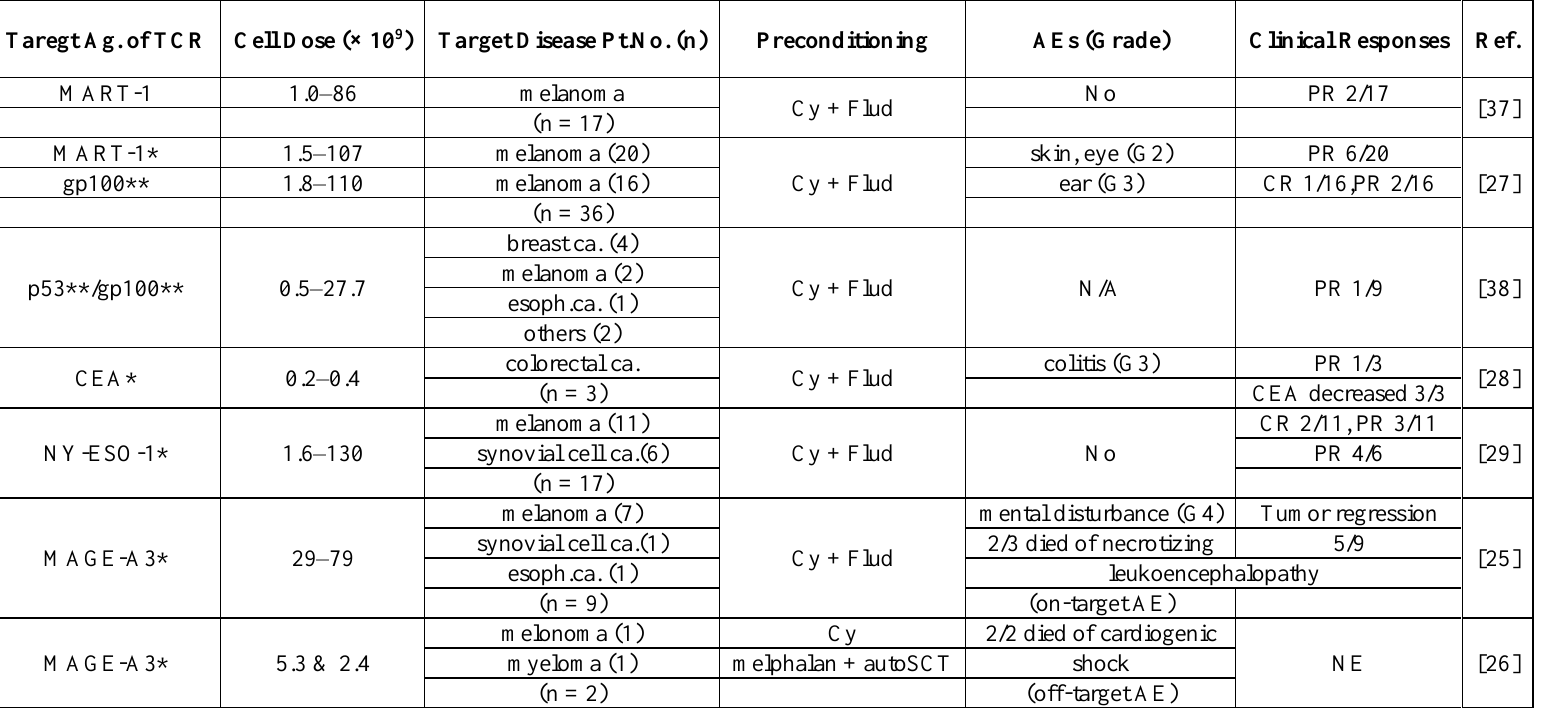
Table 1. Results from clinical trials using TCR-T